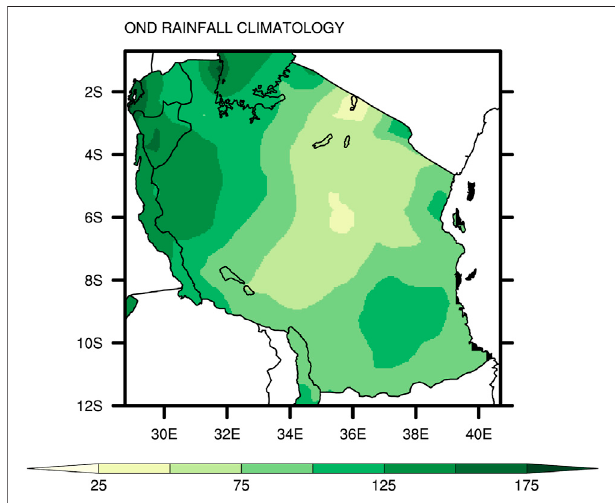
FIGURE 2 | Map of the seasonal climatological (OND) distribution of precipitation (mm month − 1 ) in Tanzania during 1950 – 2017.